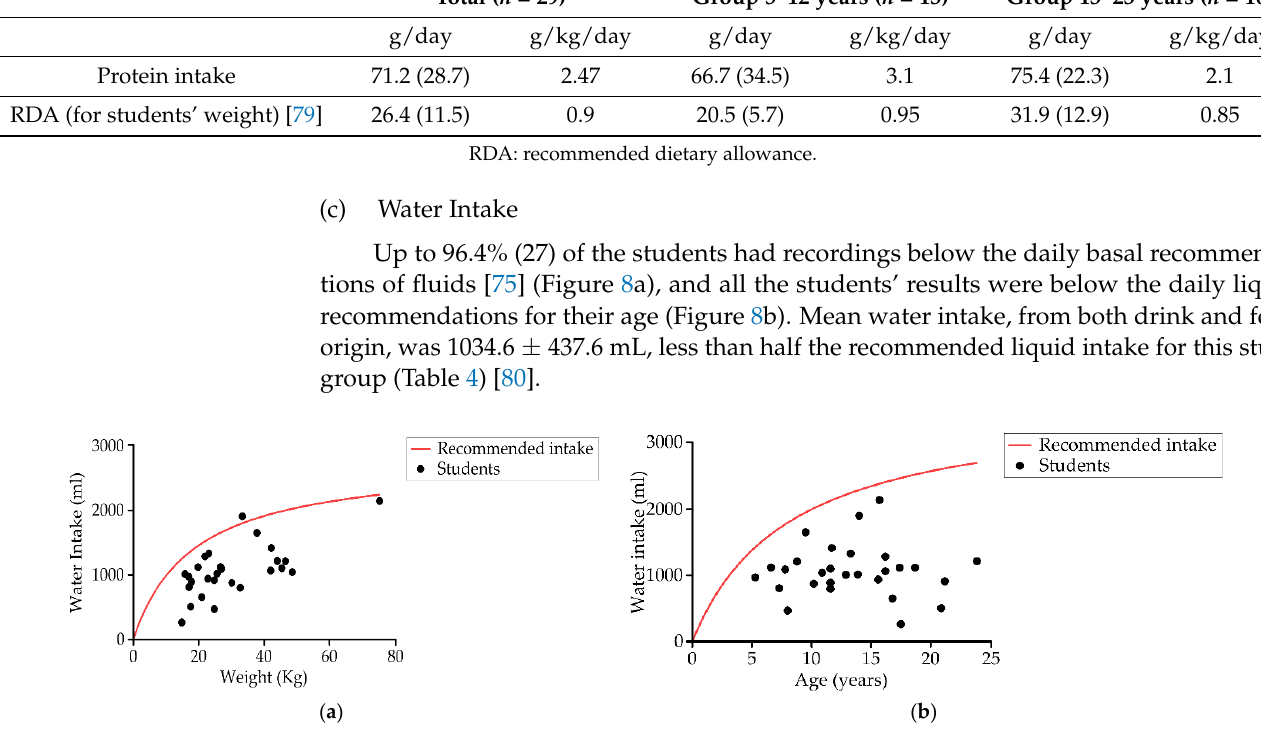
Figure 8. Relationship between ( a ) student water intake and weight, and ( b ) water intake and age compared to basal liquid recommendations [75] and liquid recommendations (European Food Safety Authority, EFSA) respectively [80] ( n = 28). Table 4. Assessment of water intake with basal needs and daily fluid recommendations, mean (SD).